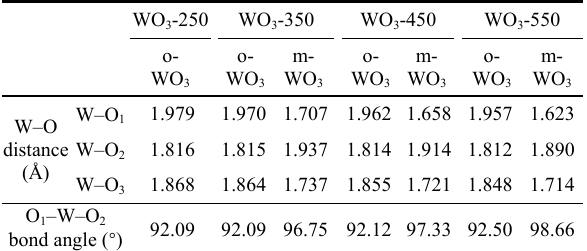
Table 1 Bond lengths and bond angles of four samples